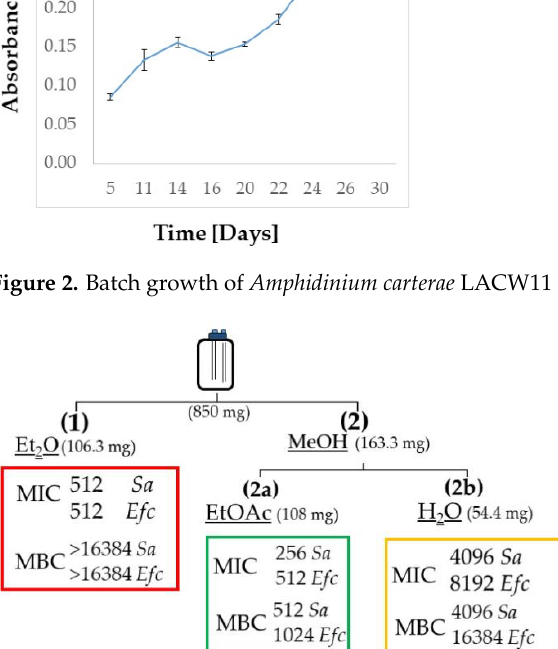
Figure 2. Batch growth of Amphidinium carterae LACW11 in f/2 medium monitored at λ = 600 nm.